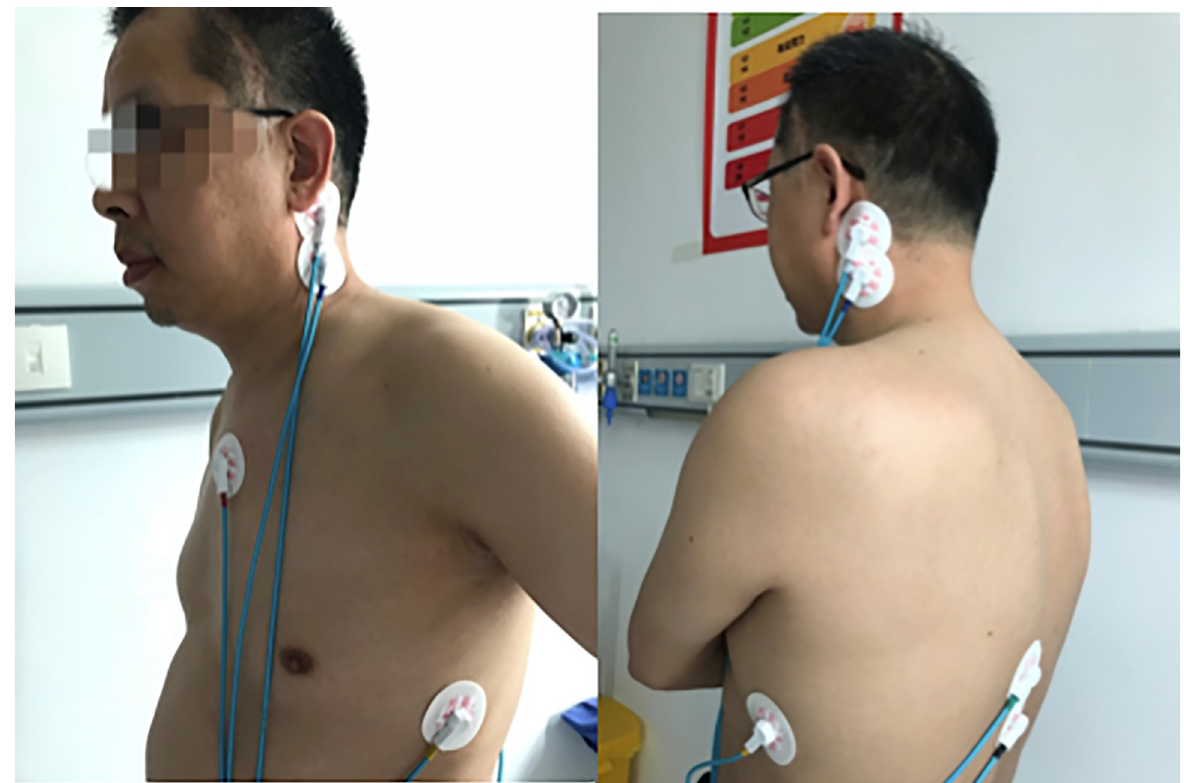
Fig 1. Placement of electrodes (with patient